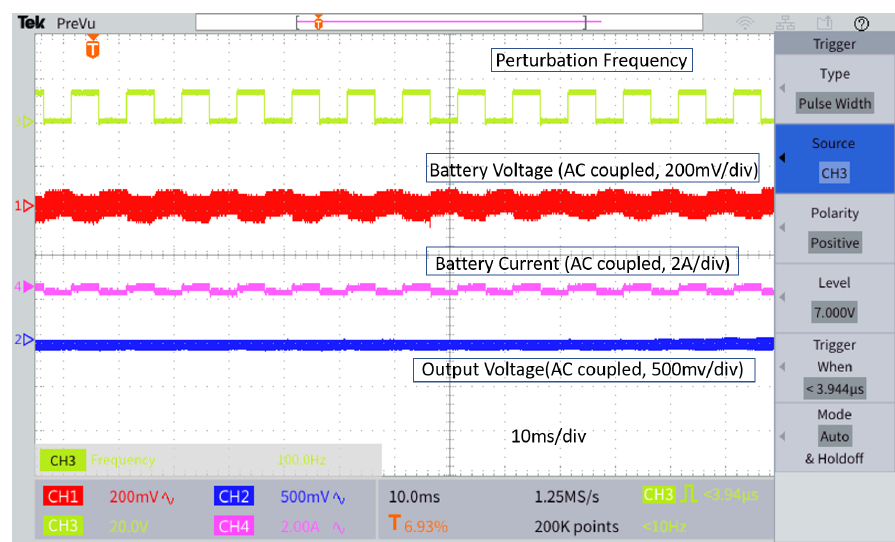
Figure 6. The experimental waveforms of the proposed SRC perturbation